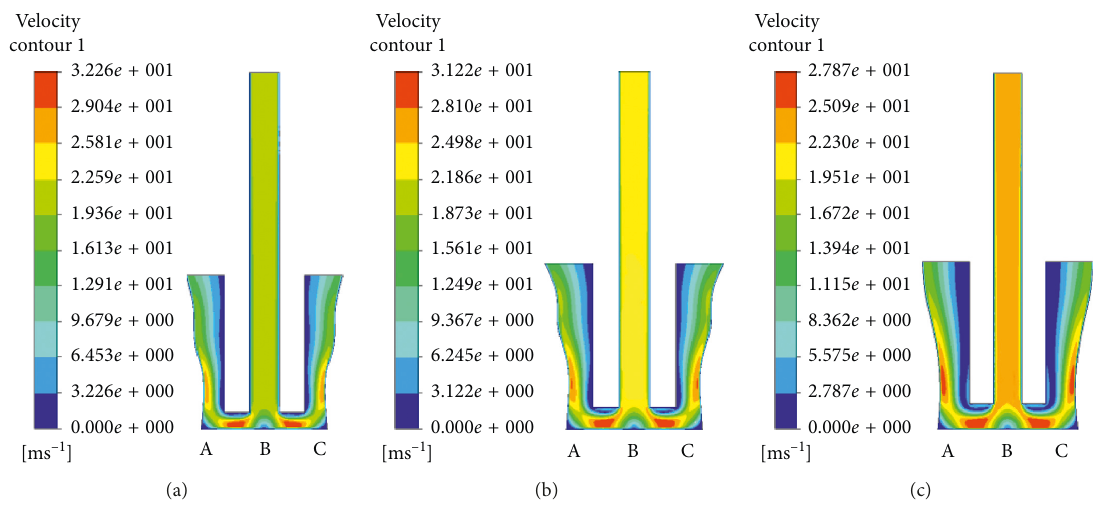
Figure 14: Electrolyte flow velocity distribution under different applied voltages. (a) U � 7V, ξ � 9% (wt.%). (b) U � 9 V, ξ � 9% (wt.%). (c) U � 13 V, ξ � 9%